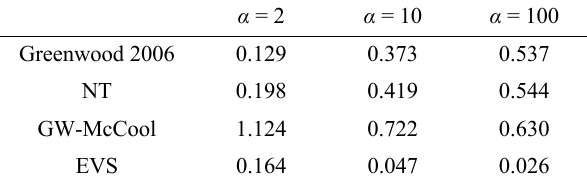
Table 4 The pressure change in the distance different models. More realistic surfaces have a high value of α . We have the closest result to Amontons’ law with Gumbel distribution in GW-McCool distribution.